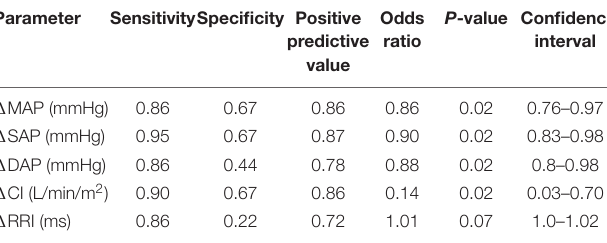
TABLE 5 | Performance diagnostics and odd’s ratio for P2 significant